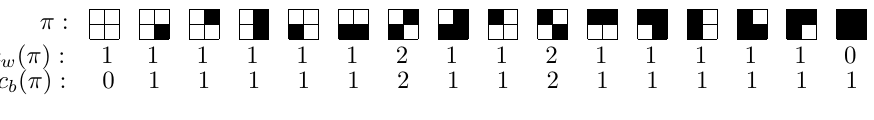
Figure 1: All possible coloring grids in G 2 , 2